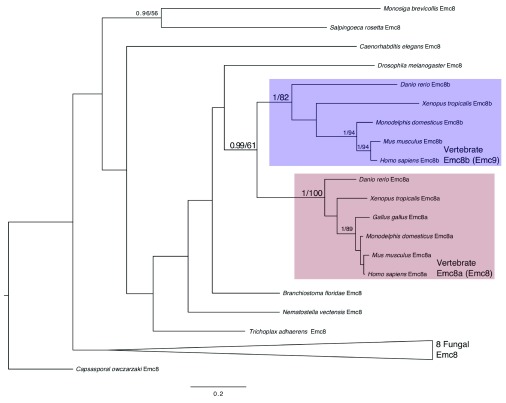
Phylogenetic analysis of opisthokont Emc8/9 proteins.Proteins were aligned using MUSCLE (
Edgar, 2004) and manually adjusted as needed using Mesquite (
http://mesquiteproject.org). Phylogenetic tree reconstructions were carried out using MrBayes v3.2.2 (
Ronquist
et al., 2003) for Bayesian analysis. Maximum likelihood bootstrap values were obtained using RaxML (
Stamatakis, 2006) with 100 pseudoreplicates using the LG model (
Le & Gascuel, 2008). Support values: MrBayes/RAxML. Only support values >0.90/50 are shown.